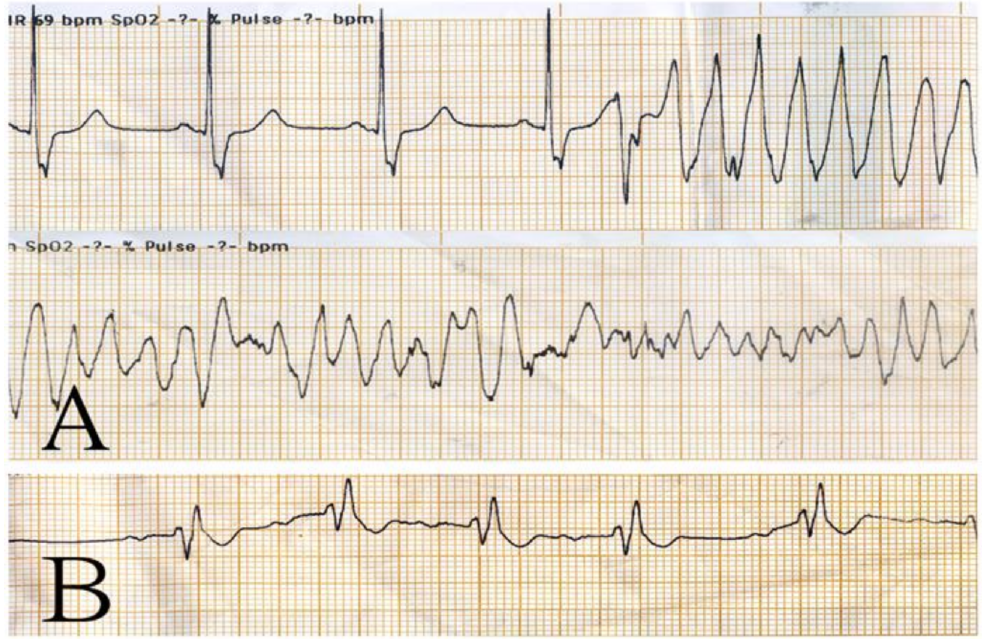
Figure 2. ECG strips were obtained when the patient collapsed ( A ). After two rounds of double sequential defibrillation ( B ), the ECG started to show ventricular defibrillation and returned to sinus